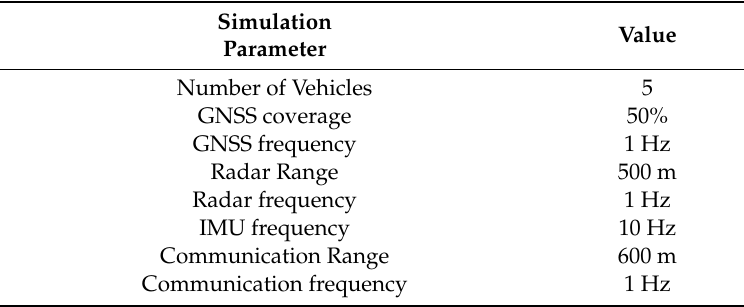
Table 1. Scenario